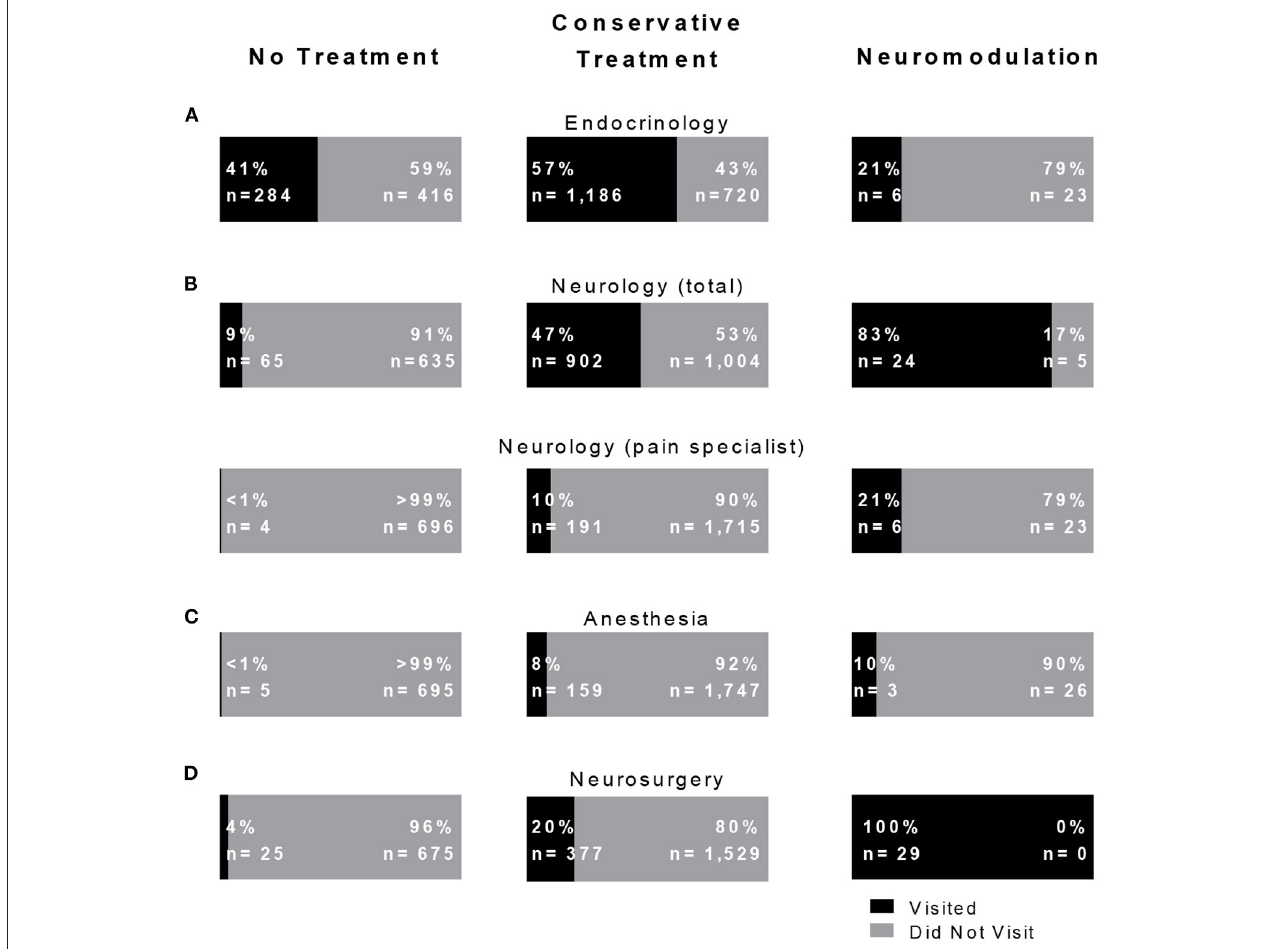
FIGURE 2 | Non-conservatively and conservatively treated painful diabetic neuropathy (PDN) patients visit endocrinology but not neurosurgery. The percentage of PDN patient per treatment group who visited to (A) endocrinology, (B) neurology (total) and the subset of neurology that visited neurology pain specialists, (C) anesthesia, and (D)